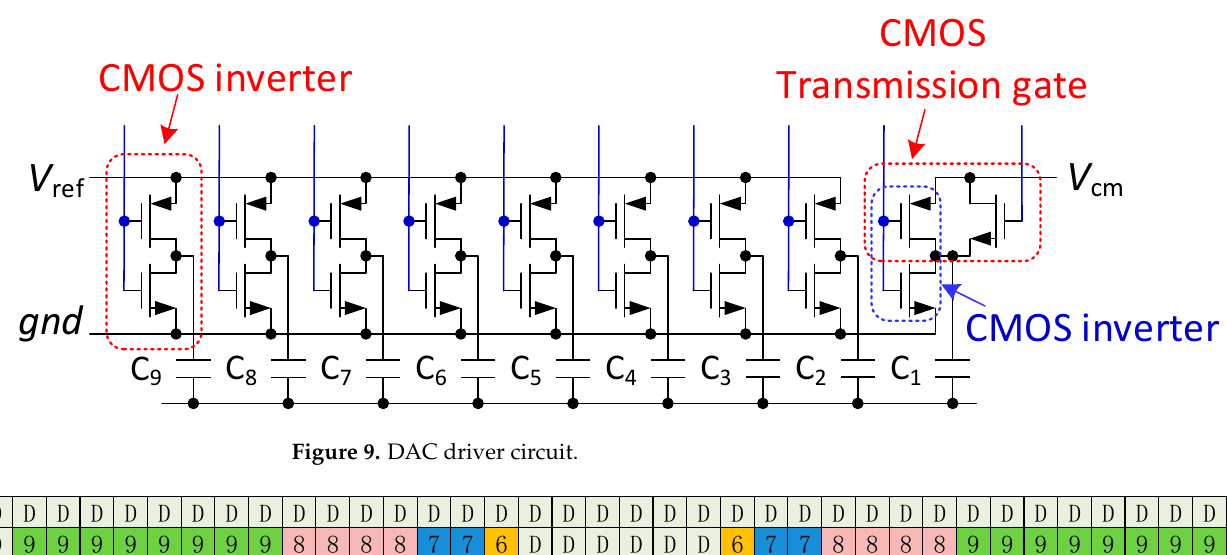
Figure 9. DAC driver circuit.